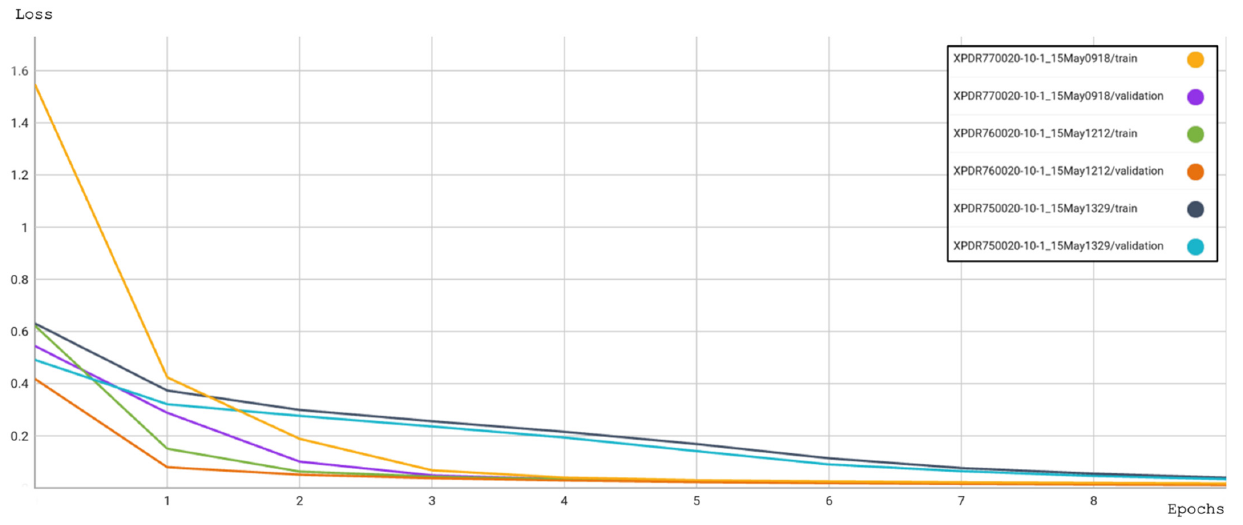
Figure 13. Emergency situations: model loss.